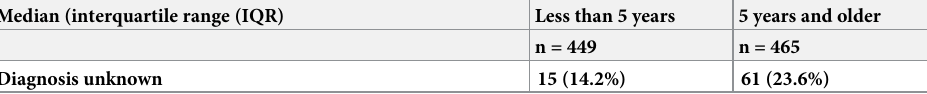
There were a number of cases in which the IMS flagging for bacteremia was false negative and in which IMS flagging for bacterial infection was false positive ( Table 4 ). Since the IMS cannot differentiate bacteremia from bacterial infections, a false-positivity rate for bacteremia alone cannot be calculated. In total 9/116 (7.7%) confirmed bacteremia cases were flagged as either viral infection (n = 6), malaria (n = 2) or infection of unknown origin (n = 1). The majority (n = 5) were invasive non-Typhoidal Salmonella (iNTS) cases among children below five years. Eight were blood culture confirmed, one was Polymerase Chain-Reaction (PCR) confirmed. In three cases antibiotics had been taken prior to inclusion to the study. In total 103 non-bacterial cases were flagged as bacterial; they comprised patients with malaria (n = 64), viral respiratory tract infection (n = 37), and one patient each with viral hepa- titis and combined malaria/viral infection.